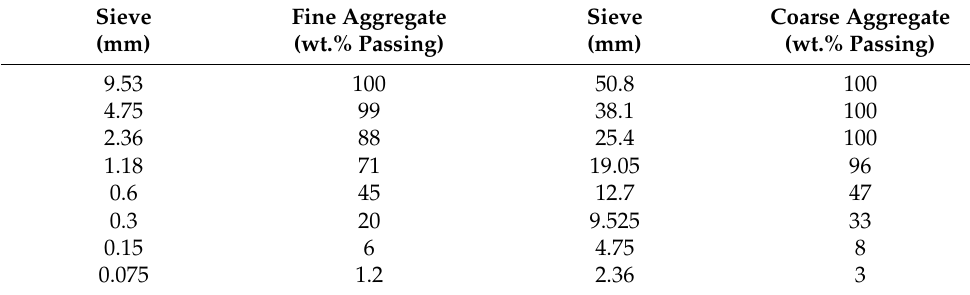
Table 3. Gradation of aggregate.